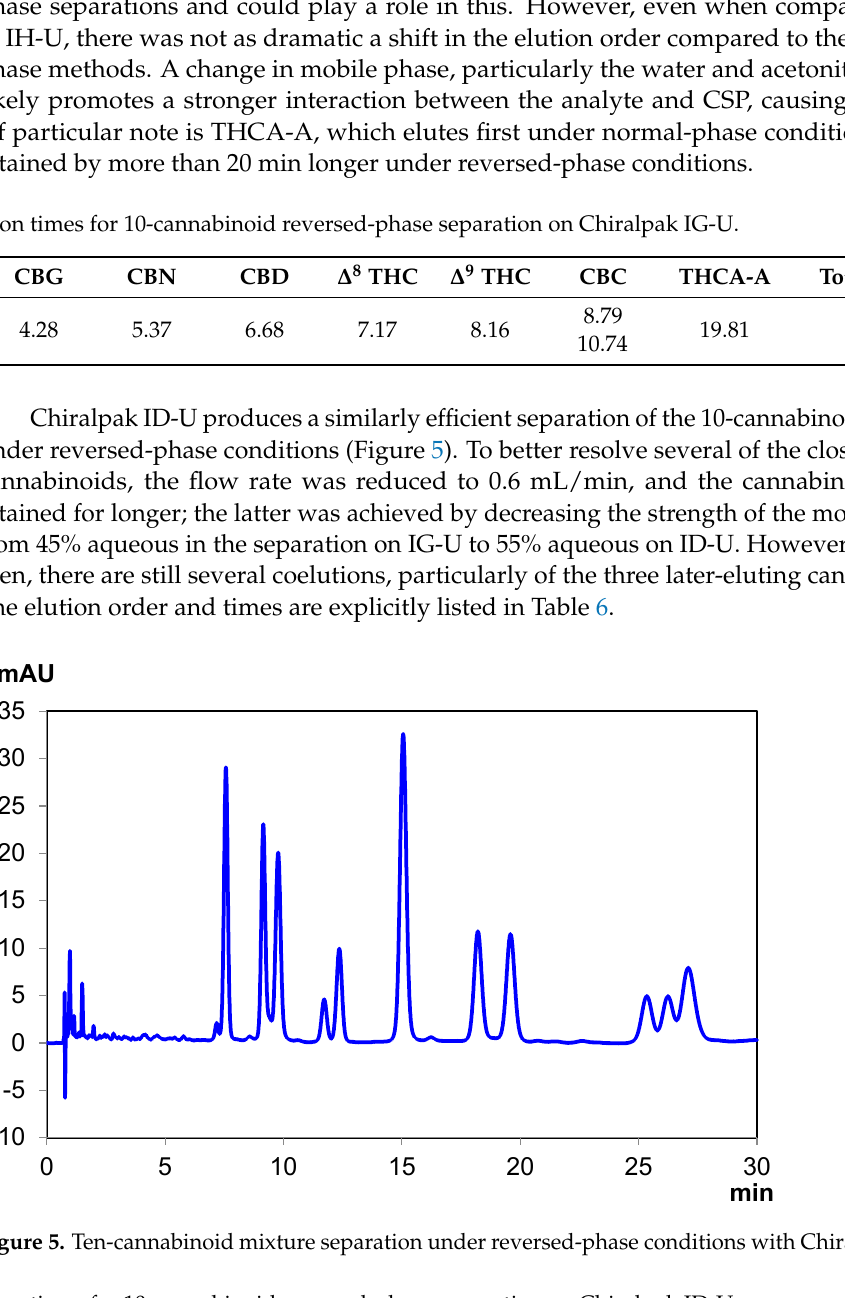
Table 5. Elution times for 10-cannabinoid reversed-phase separation on Chiralpak IG-U.